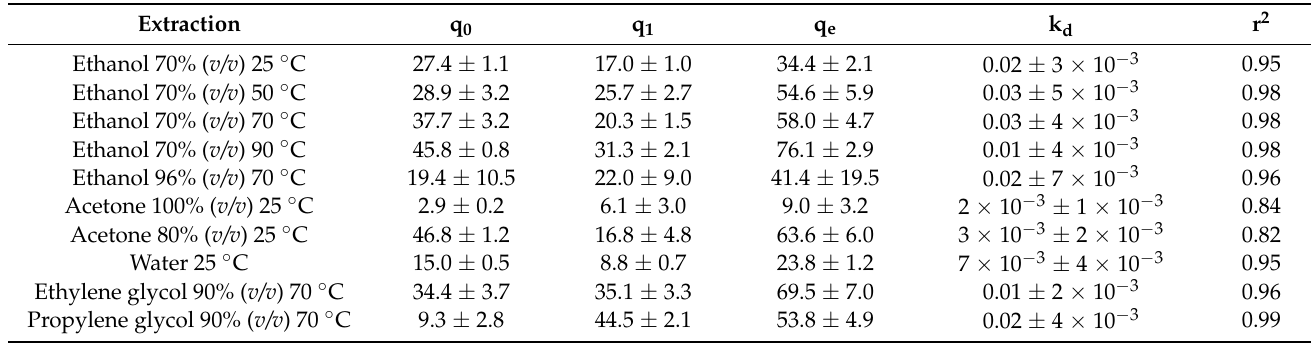
Table 3. Kinetic parameters from the extraction process of GP measuring total phenolic content (TPC) by Folin–Ciocalteu’s method; q 0 , q 1 , and q e are measured in mg GAE/gds, while k d units are gds/(mg GAE ·